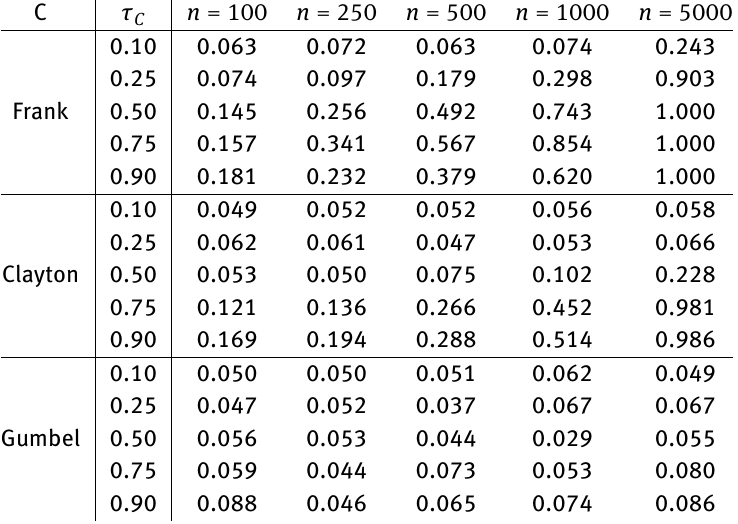
Table 6: d = 2 : Empirical power of the test for ellipticity with significance level α = 0.05 based on the test statistic T n : rate